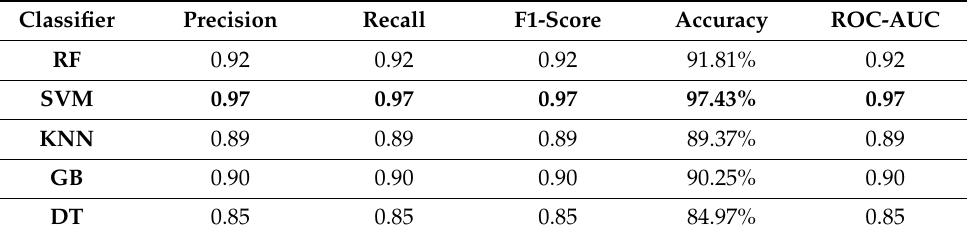
Table 4. Results after parameter tuning.